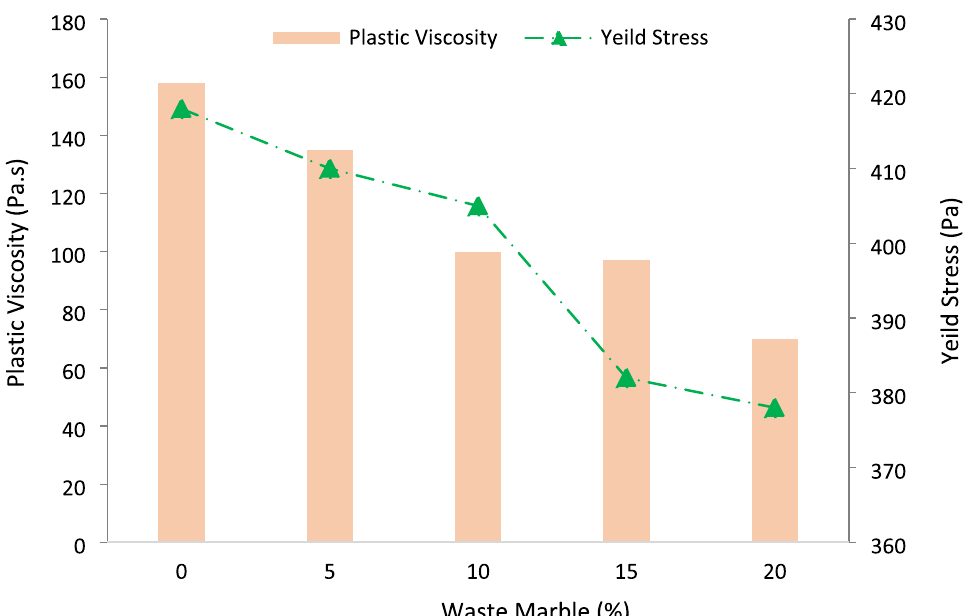
Fig. 7 Plastic viscosity and yield stress (Boukhelkhal et al.,